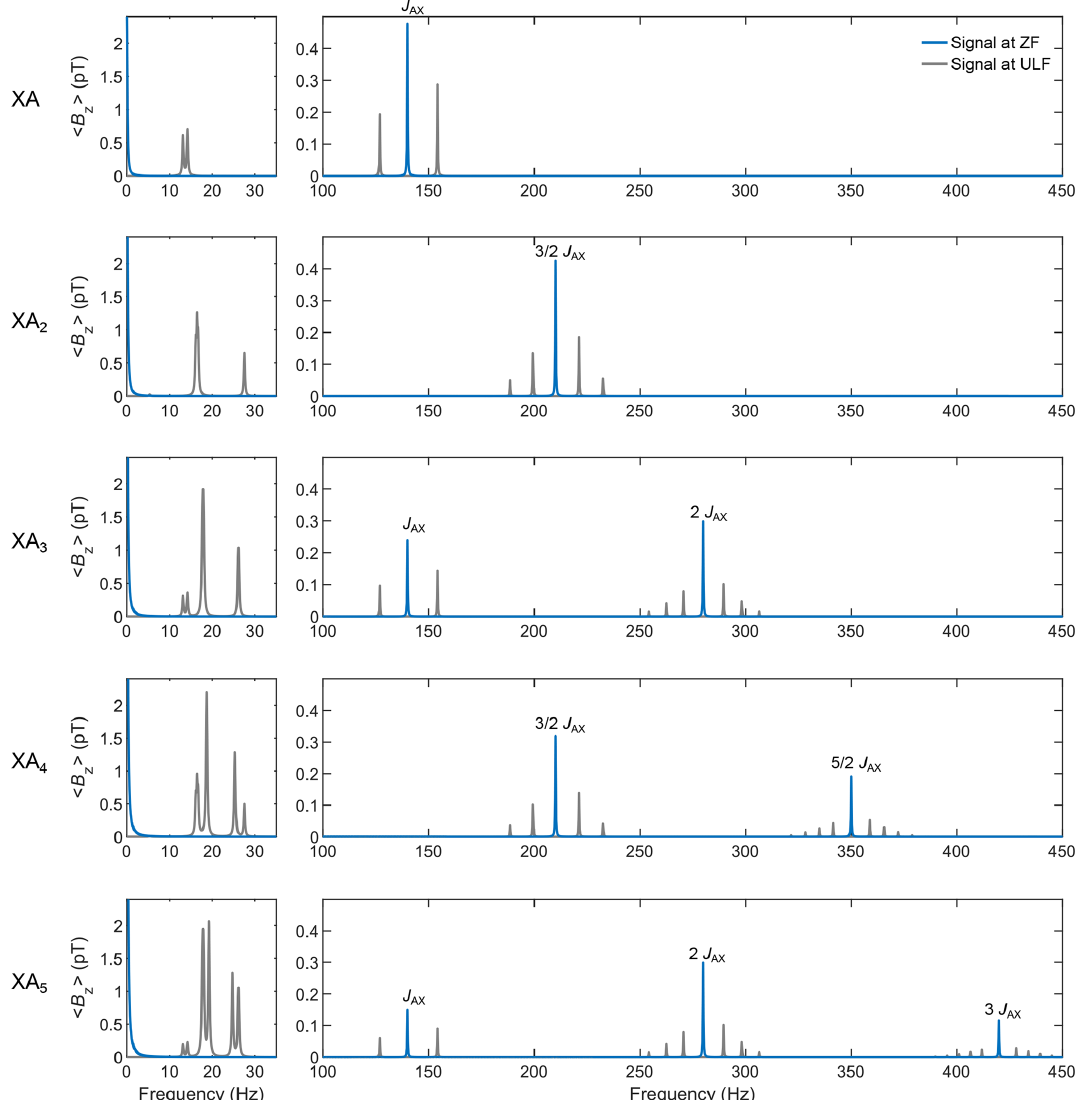
Figure 6. Simulation of ZF and ULF spectra after sudden field drop for XA, XA 2 , XA 3 , XA 4 , and XA 5 spin systems with a J coupling of 140Hz between X and A spins and 10Hz among A spins. The time domain signal was computed by propagating the density matrix under the effect of the Hamiltonian for a total time of 5s (parameter t aq ), discretized into 4096 points (parameter K ), and corresponding to time intervals d t of 1.2207ms (parameter τ D ). A monoexponential apodization function was applied to the time domain signal, with a coherence time constant T 2 of 1s. The apodized time domain signal was Fourier transformed with zero-filling to 32768 points.